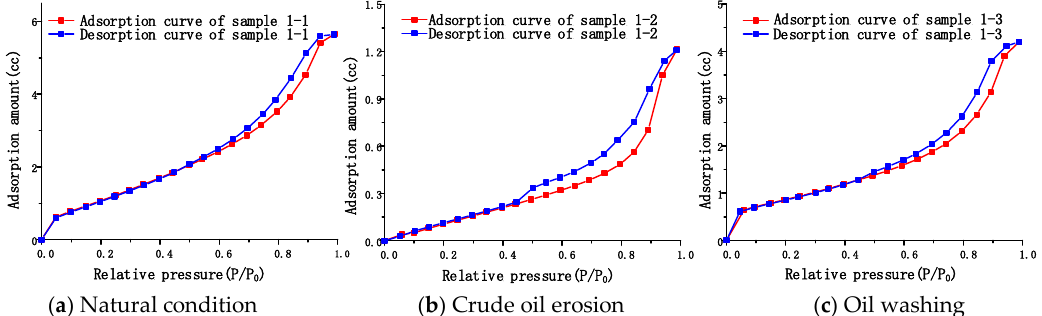
Figure 6. The adsorption isotherms of rock salt samples under different sample treatment conditions.